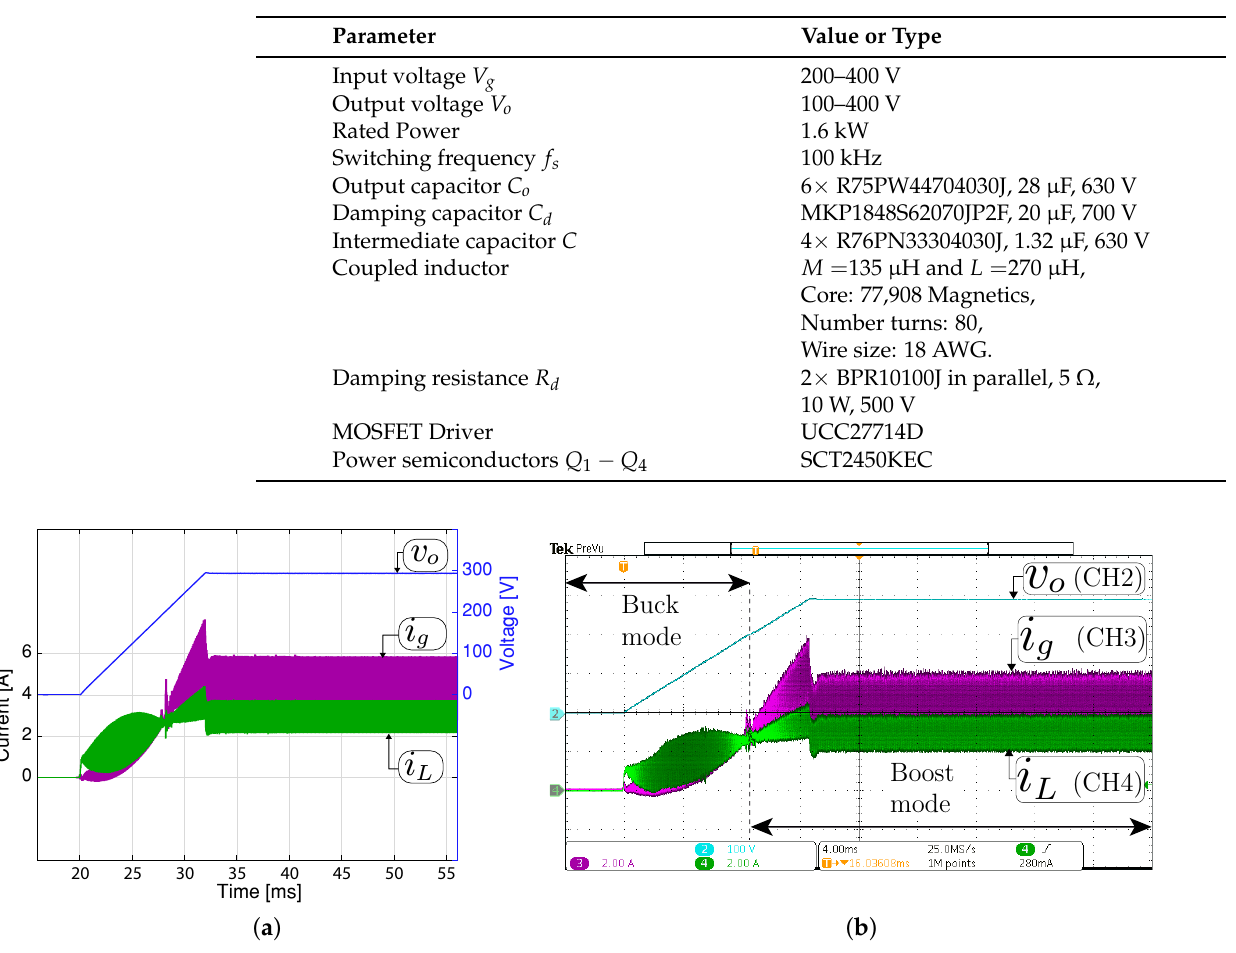
Table 3. Selected components and parameters for the buck–boost converter.